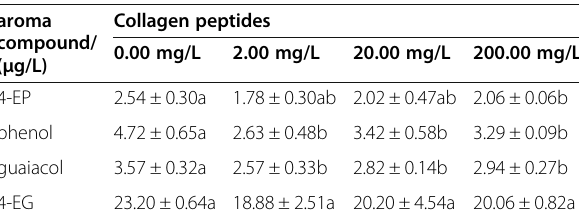
Table 2 Effect of CPs on the content of phenolic compounds in the volatile components in 52 % ethanol-water solution as determined by